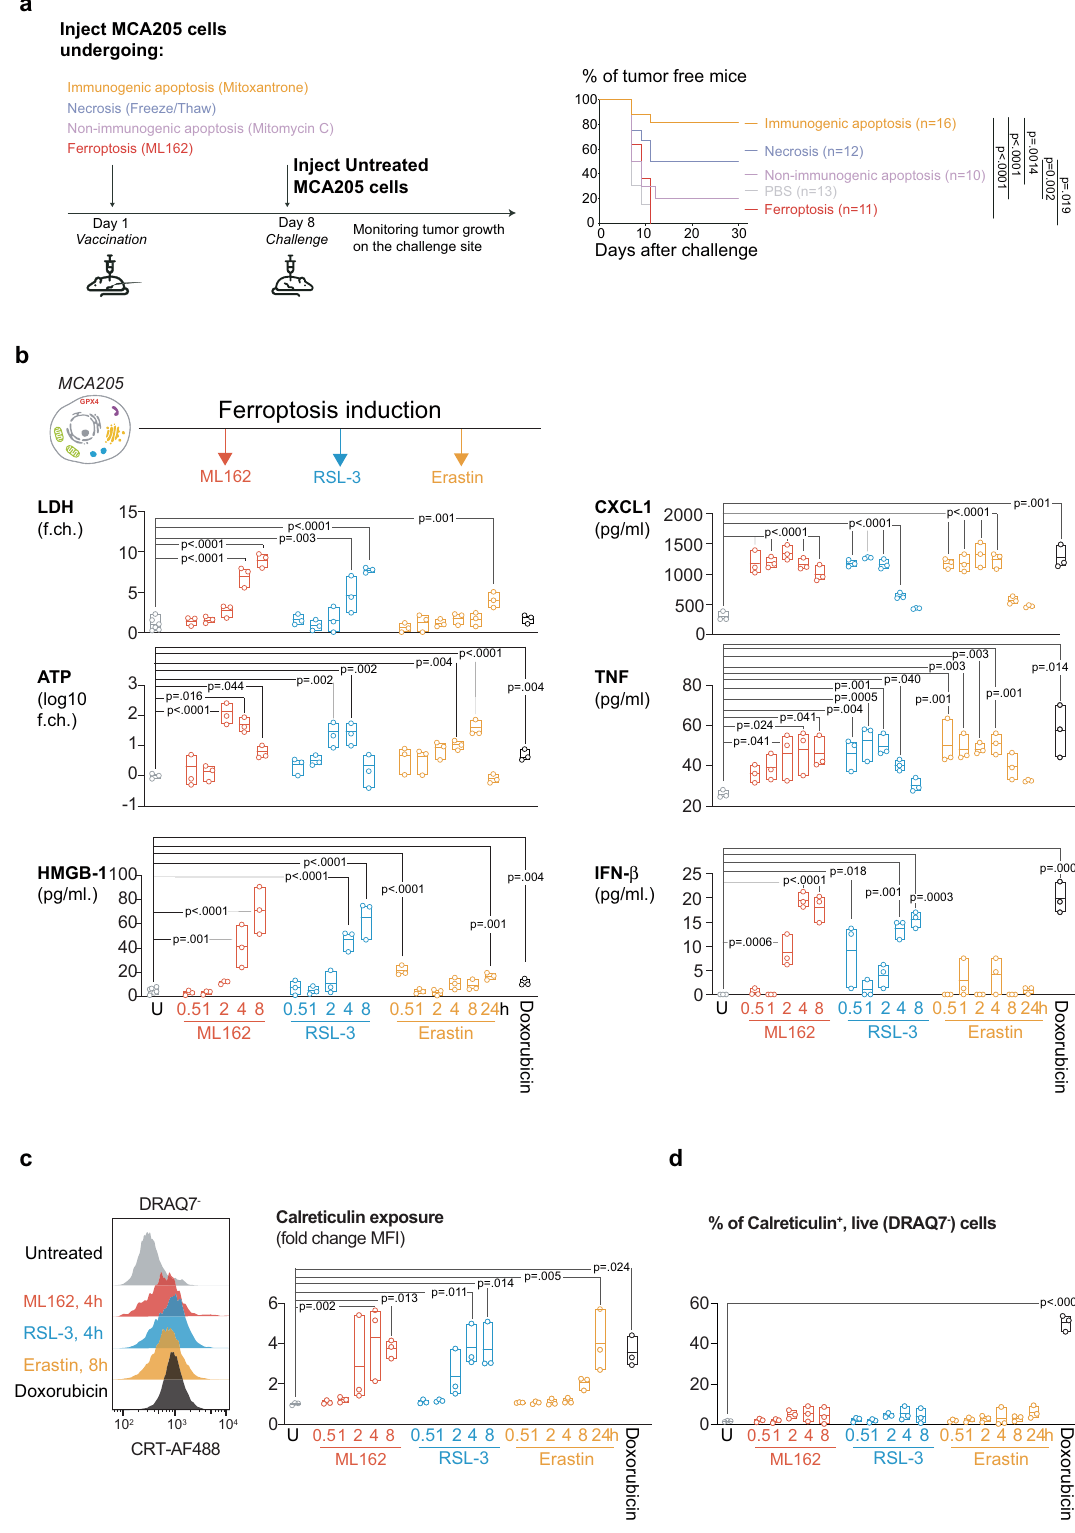
vaccination experiment without the risk of tumor growth on the vaccination site. Prophylactic vaccination with neither initial nor terminal ferroptosis elicited a protective response against a challenge with living tumor cells underlining the absence of immunogenicity of ferroptotic cancer cells following prophylactic vaccination (Fig. 2g). Tumors originating from the challenge